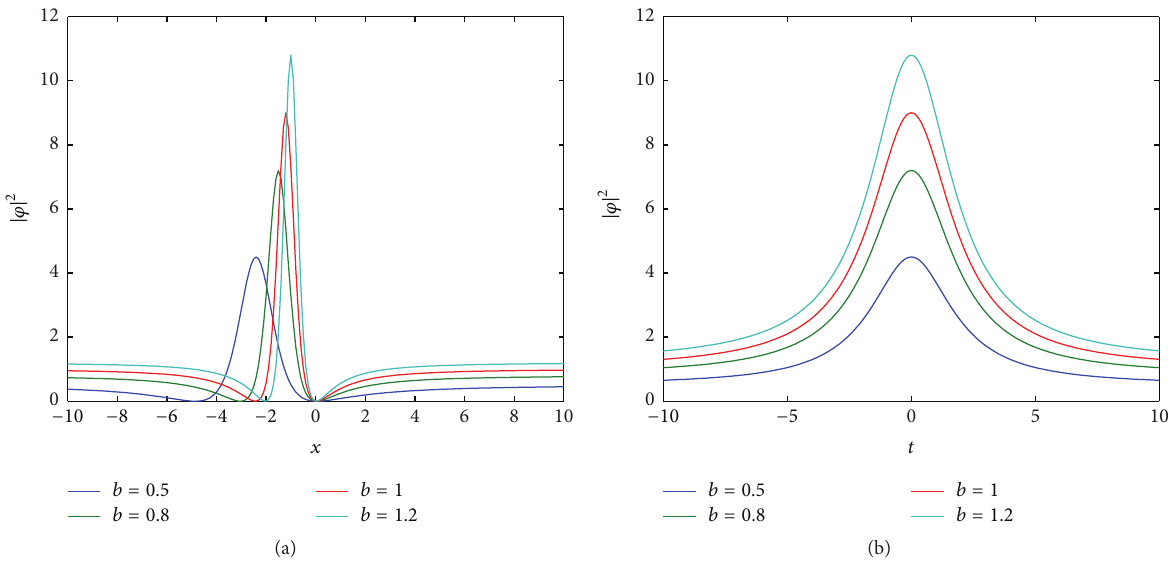
Figure 3: (a) Coordinate variation of the amplitude of the first-order rogue waves with the gravity fields 𝑏 = 0.5 , 𝑏 = 0.8 , 𝑏 = 1.2 , and 𝑏 = 1.5 . (b) Time variation of the amplitude of the first-order rogue waves with the gravity fields 𝑏 = 0.5 , 𝑏 = 0.8 , 𝑏 = 1.2 , and 𝑏 = 1.5 .